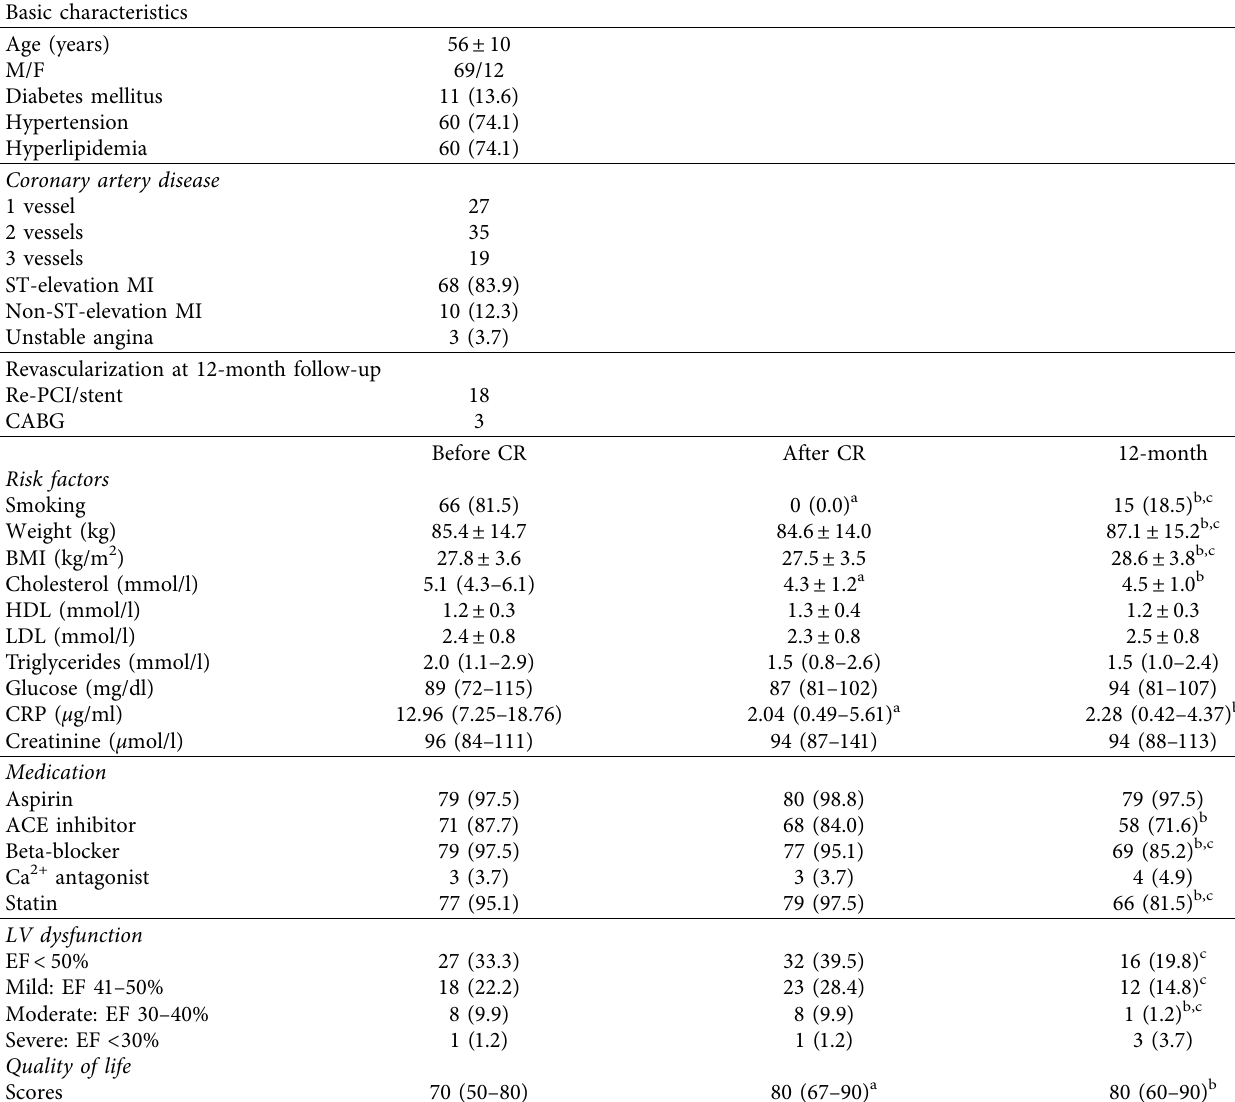
Table 1: Basic clinical data in patients before and after CR as well as at 12